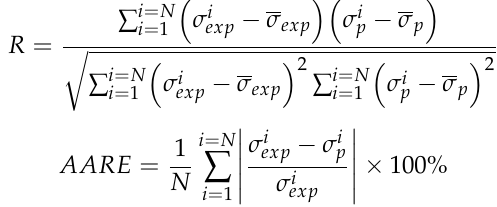
Figure 9 depicts the linear regression between experimental and predicted values of Mg-6Li alloy at four temperatures and different strain rates (0.001 s − 1 , 0.01 s − 1 , 0.1 s − 1 and 1.0 s − 1 ). Standard statistical parameters R (correlation coefficient) and AARE (average absolute relative error) are used to evaluate the prediction ability of the model. Which are defined as